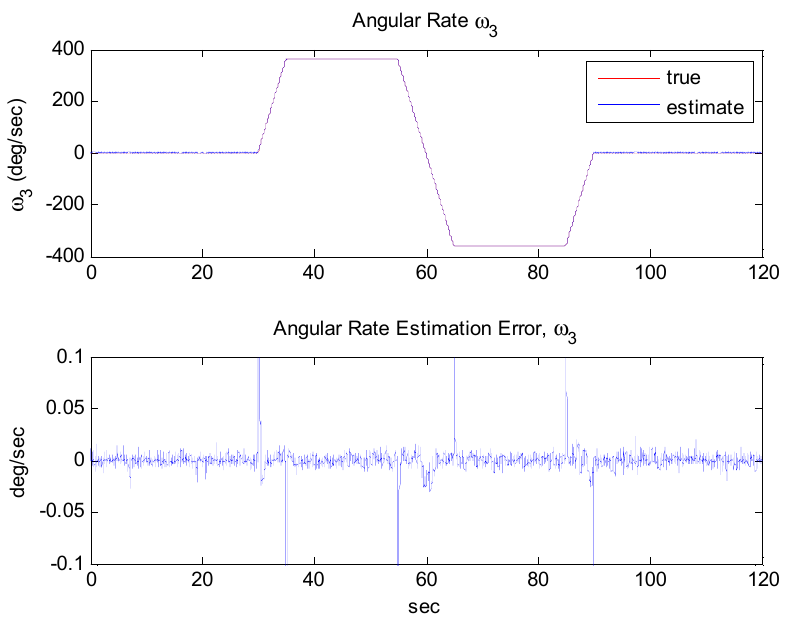
Figure 6. Angular rate estimation error of ω